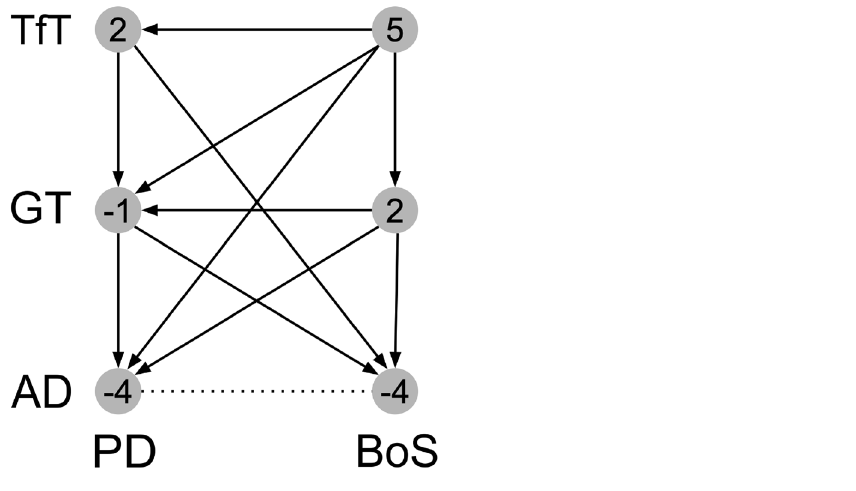
Figure 1. Predicted complexity relations. The vertices of the graph represent states, that is, pairs of opponent’s strategy and stage game. The directed edges represent the order, pointing to the least complex of the two vertices. The others follow taking the transitive closure. The number associated with each vertex is the measure of complexity associated with the corresponding pair of opponent and stage game, computed as the difference between the number of vertices it dominates and the number of vertices that dominate